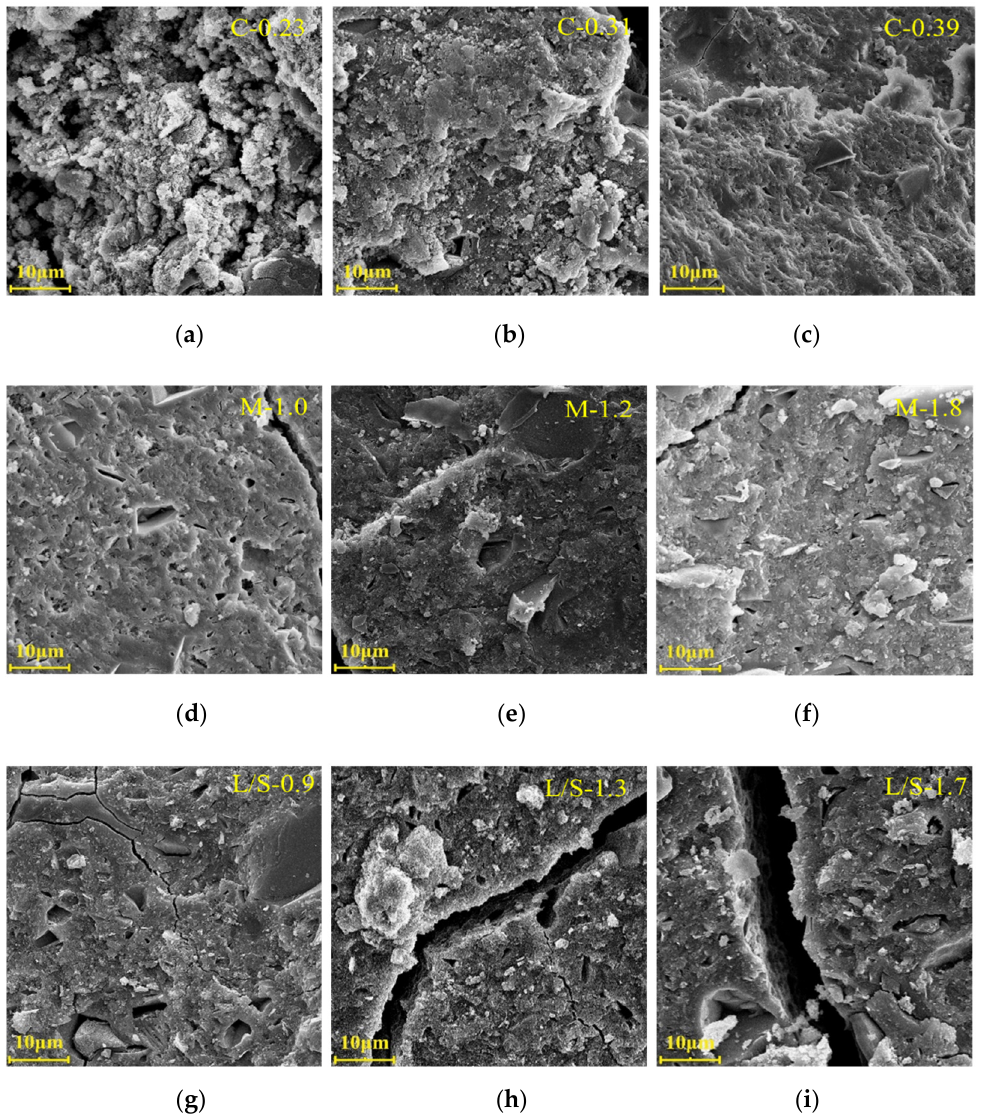
Figure 7. SEM images of MK/GGBFS-blended geopolymer pastes synthesized with varying concen- trations ( a )–( c ), moduli of alkaline activator ( d )–( f ), and L/S ratio ( g )–( i ).